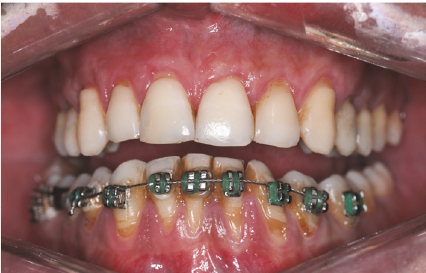
Figure 11: Stabilized mucogingival tissue with satisfactory appear- ance 45 days after the root coverage